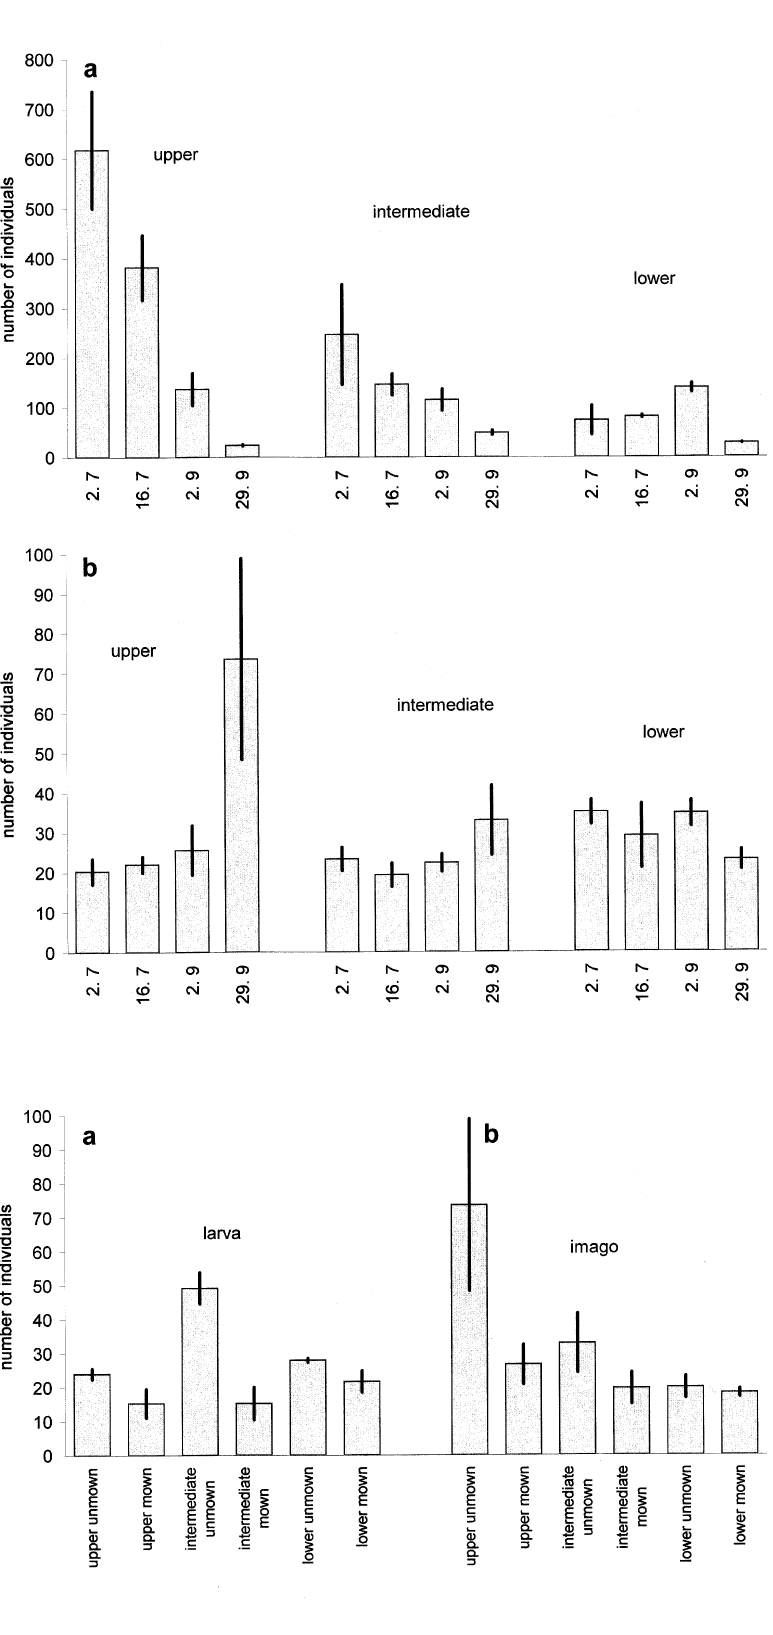
Fig. 4. Average number and standard error of Auchenorrhyncha larvae (a) and imagoes (b) in the unmown plots in 1997, from suction traps.